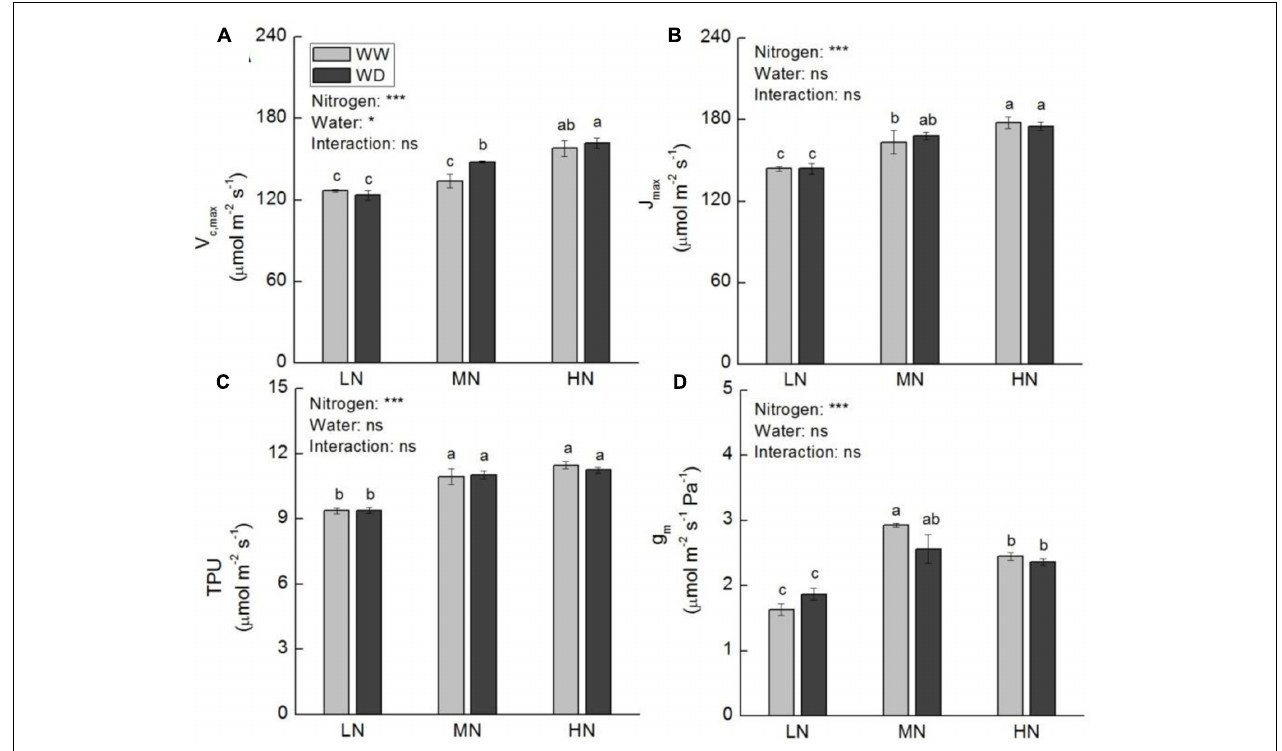
FIGURE 3 | Comparison in maximum carboxylation rate of Rubisco ( V c , max , A ), maximum electron transport rate ( J max , B ), triose phosphate utilization (TPU, C ), and mesophyll conductance ( g m , D ) of rice plants grown under different nitrogen and water conditions. Data refers to mean ± SE ( n = 4). P -values of the two-way ANOVAs of nitrogen, water, and their interaction are indicated: ns, not significant; ∗ P < 0.05; ∗∗ P < 0.01; ∗∗∗ P < 0.001. Bars with the same letter are not significantly different by LSD test. WD, water deficit; WW, well-watered.